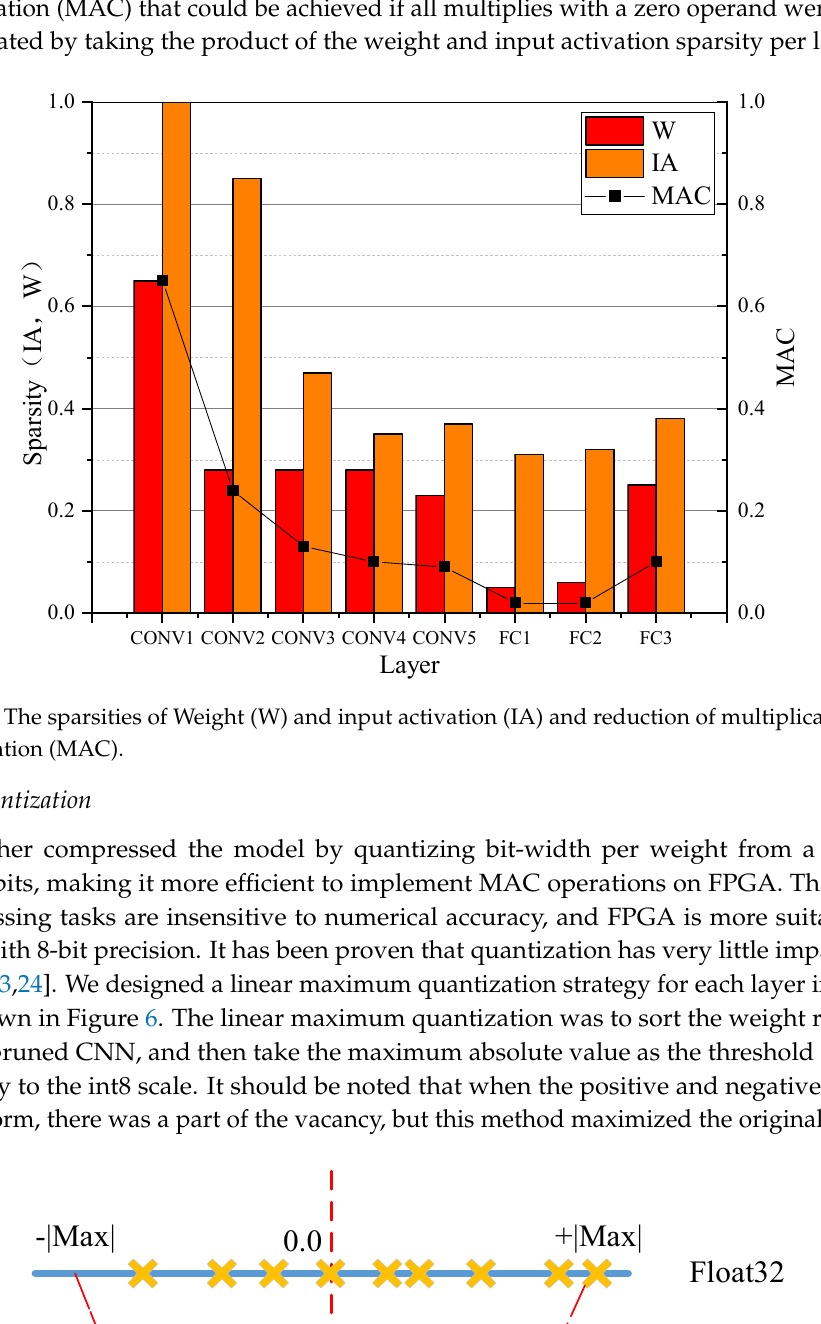
Figure 4. Top-1 accuracy loss of AlexNet in reverse-pruning.